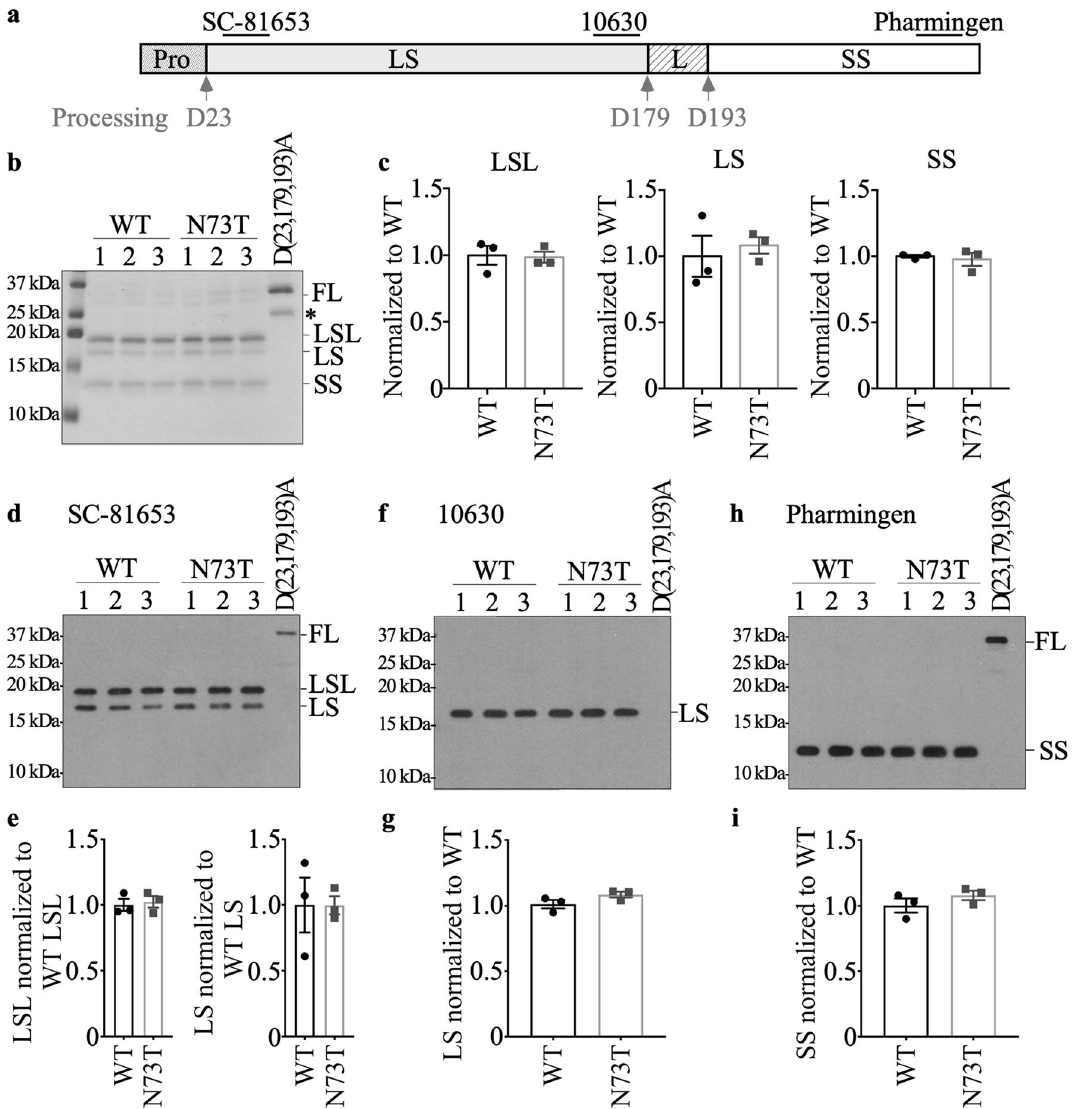
Figure 2. Self-processing of recombinant Casp6N73T zymogen. ( a ) Schematic diagram of recombinant human Casp6 zymogen showing the subunits and epitopes recognized by antibodies. The epitope for the SC-81635 antibody is unknown but located in the large subunit (LS), neoepitope for 10630 antisera detects the C-terminus of the LS of Casp6, and epitope for the Pharmingen antibody is G271-K285. Pro pro-domain, LS large subunit, L linker, SS small subunit. ( b ) Coomassie blue stain of 2 µg purified recombinant Casp6WT and Casp6N73T zymogens processed into LSL, LS and SS subunits. The unprocessed Casp6D(23,179,193)A was used as a control for the FL form. LSL large subunit with the linker, FL full length. * indicates unspecific band. ( c ) Quantification of the density of LSL, LS or SS normalized to density levels of Casp6WT from Coomassie blue stained gels. ( d,f,h ) Western blot of Casp6WT, Casp6N73T, and Casp6D(23,179,193)A with SC-81635 antibody anti-LS ( d ) , with neoepitope antisera 10630 anti cleaved LS ( f), and with Pharmingen antibody anti-SS (h) . Quantification of ( e) LSL and LS from (d), (g) LS from (f), and ( i) SS from (h). Data represents mean and s.e.m of 3 independent experiments. No statistical differences were found by unpaired student’s and Casp6N73T zymogens generated more LSL than LS (Fig. 2b) indicating preferred self-cleavage at D193, as previously observed with Casp6WT 14,33,46 . The catalytically inactive Casp6D(23,179,193)A was not processed, as expected, and migrated as full-length (FL) Casp6 at 34 kDa. The Casp6N73T zymogen generated LSL, LS, and SS at levels comparable to those of the Casp6WT zymogen (Fig. 2b,c). FL, LSL, LS, and SS of Casp6 were confirmed with western blotting against anti-FL and anti-LSL Casp6 antiserum (Fig. 2d,e), neoepitope antiserum recog- nizing Casp6 cleaved at D179 (Fig. 2f,g), and anti-SS antibodies (Fig. 2h,i). No difference in the levels of each subunit between Casp6WT and Casp6N73T was detected (Fig. 2e,g,i). These results indicate that Casp6N73T zymogen self-processing is similar to that of Casp6WT zymogen.